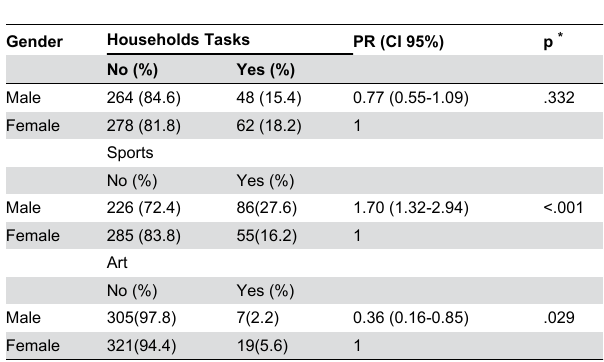
Table 1. Association between children’s tasks and gender. Table 2. Association between sociodemographic variables, children’s tasks, personality traits and sleep bruxism.